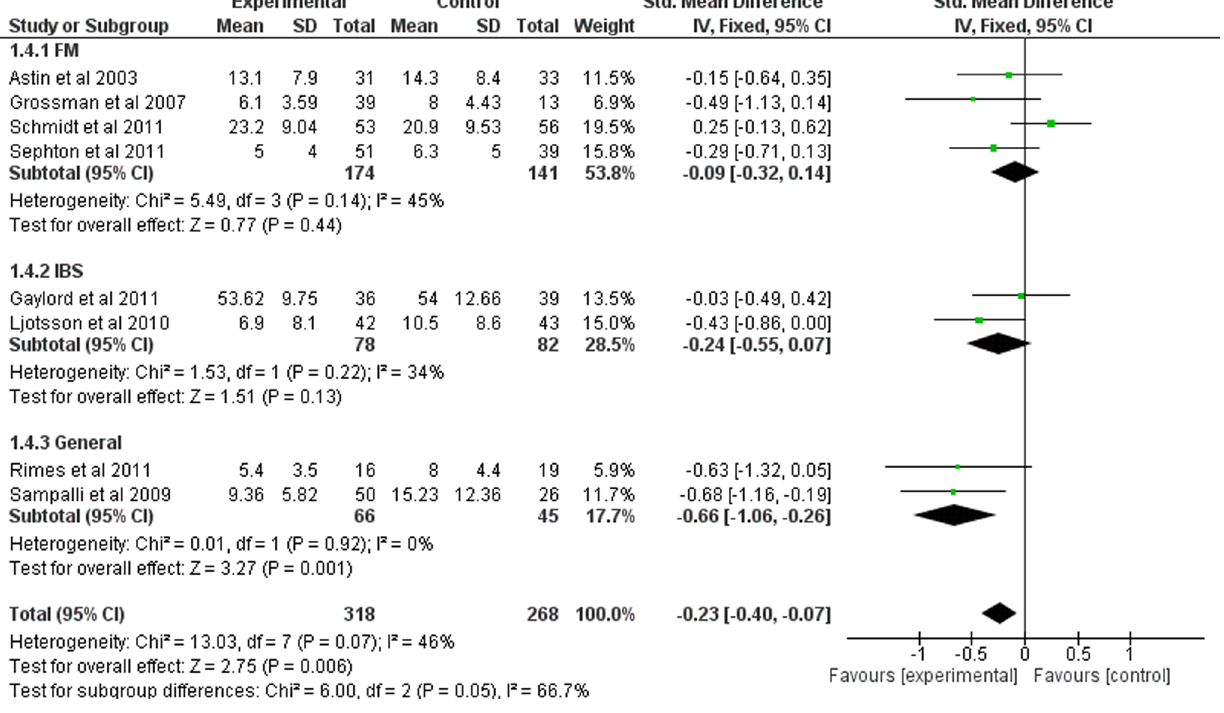
Figure 11. Forest plot showing the effect of mindfulness therapy on the depression outcome measure. Standardised mean difference between experimental and control group indicates that the mindfulness-based therapy group showed significantly more improvement than the control group, in only general somatization.